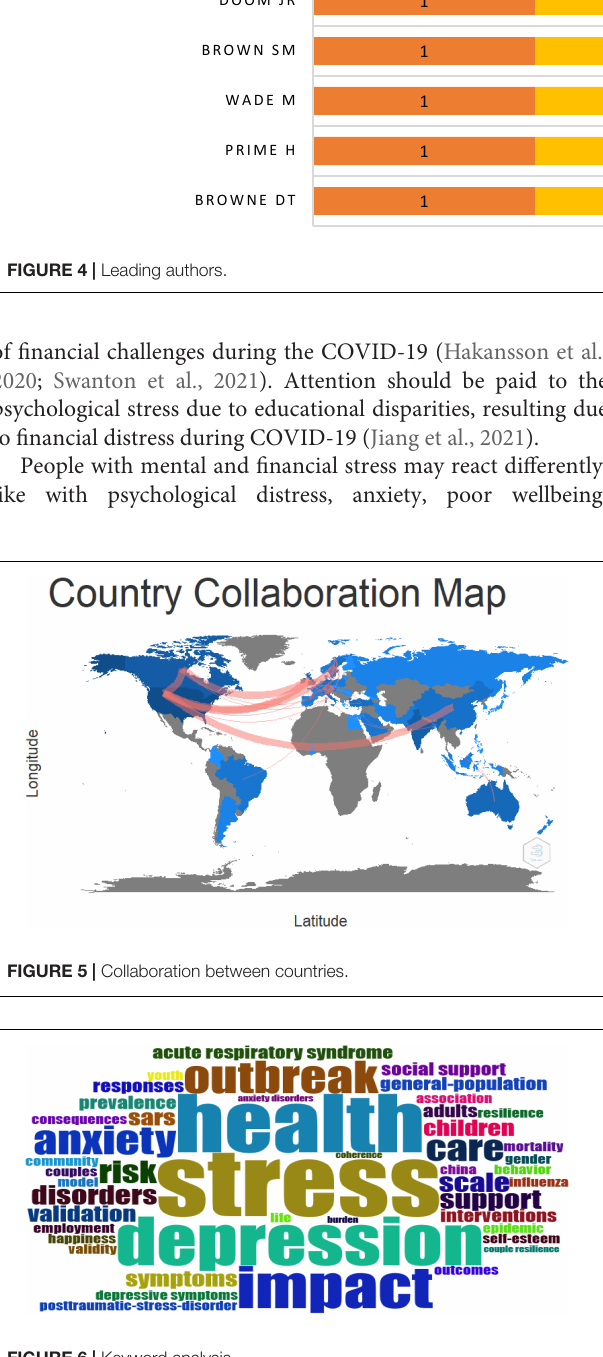
FIGURE 6 | Keyword analysis.